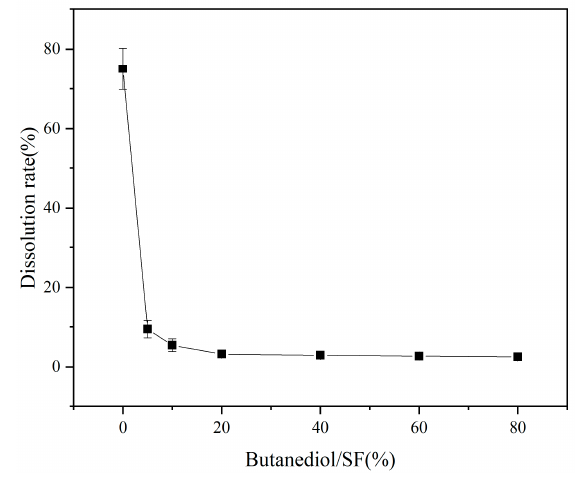
ff erent proportions of SF ( w / w